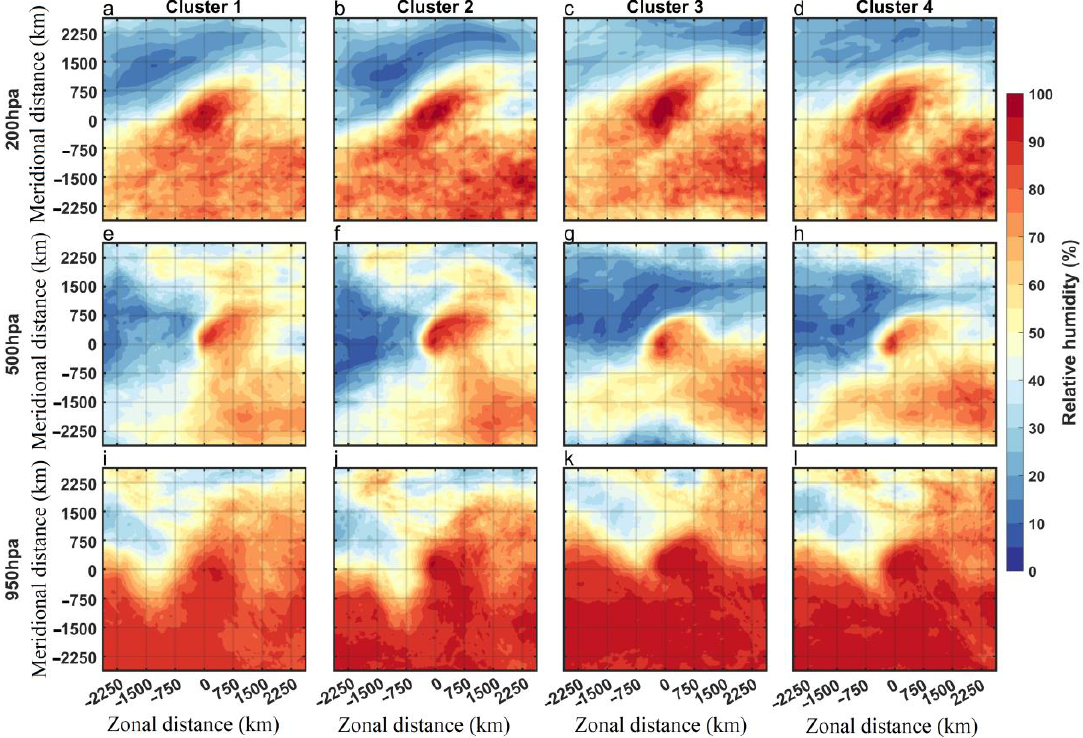
Figure 4. Mean composites of relative humidity (RH, %) obtained from ERA5 data for each cluster at different levels 200 hPa ( a – d ), 500 hPa ( e – h ), and 950 hPa ( i – l ). different levels 200 hPa ( a – d ), 500 hPa ( e – h ), and 950 hPa ( i – l